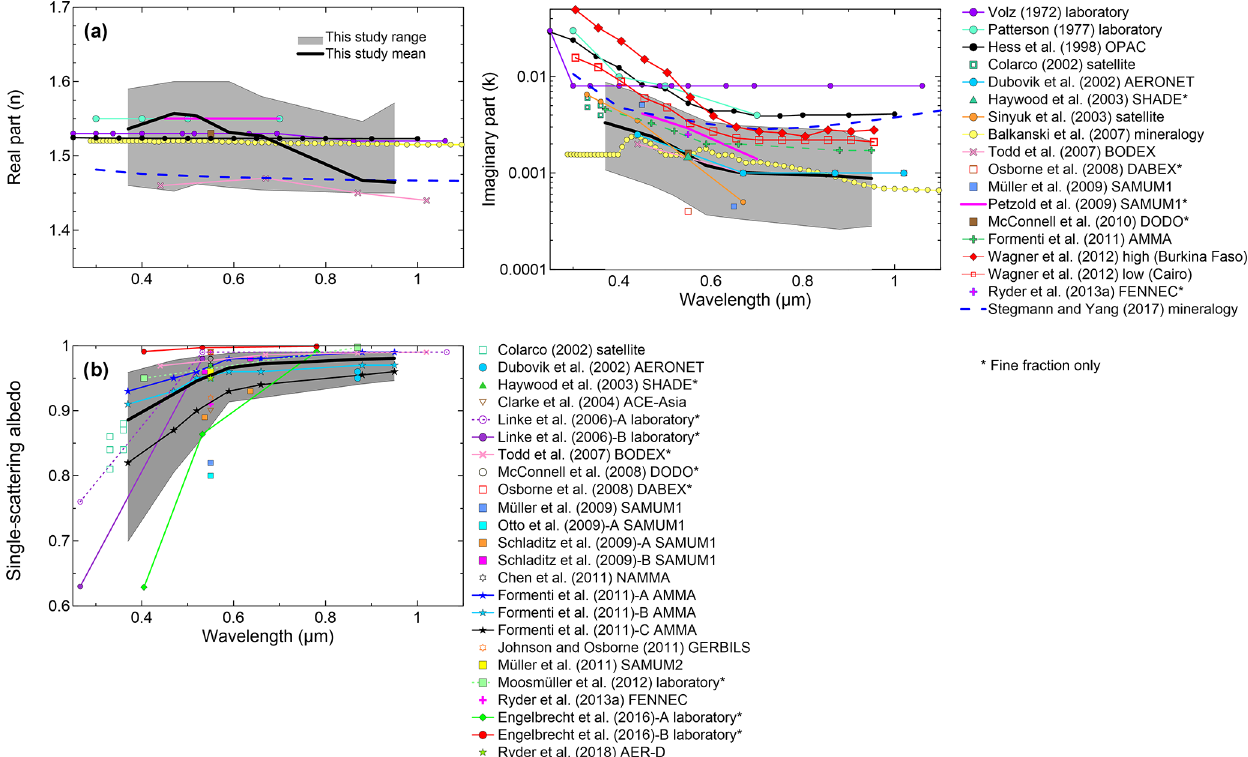
Figure 8. Comparison of the results obtained in this study with literature-compiled values of the (a) dust real and imaginary parts of the refractive index ( n , k ) and (b) single-scattering albedo (SSA) in the SW spectral range. The regions in grey indicate the full range of variability obtained in this study, and the thick black lines are the means of n , k , and SSA obtained for the different aerosol samples. Literature values include estimates from ground-based and aircraft observations during field campaigns, laboratory studies, AERONET inversions, and estimates from dust mineralogical composition. Data are in some cases for the full dust size distribution, while in others only the fine fraction below about 2µm is represented (identified with *). The main provenance of the dust and datasets from the literature is provided in the following: Volz et al. (1972) data are for rainout dust collected in Germany; Patterson et al. (1977) data are for Saharan dust; Hess et al. (1998) data are from the OPAC database; Colarco et al. (2002) data are for dust from Dakar, SAL, and Tenerife; Dubovik et al. (2002) include data from the Bahrain–Persian Gulf and Solar Village–Saudi Arabia AERONET stations; Haywood et al. (2003) include dust from Mauritania; Sinyuk et al. (2003) data are from Cape Verde, Dakar, and Burkina Faso; Clarke et al. (2004) include Asian dust offshore of China, Japan, and Korea; Linke et al. (2006)-A includes dust from Cairo; Linke et al. (2006)-B includes dust from Morocco; Balkanski et al. (2007) calculated data from the mineralogical composition assuming a 1.5% hematite mass fraction in dust; Todd et al. (2007) data are from Bodélé; Osborne et al. (2008) data are from Niger; Otto et al. (2009), Petzold et al. (2009), Schladitz et al. (2009), and Müller et al. (2009, 2011) include dust originated mostly in Morocco; McConnell et al. (2008, 2010) include dust from Niger–Senegal; Chen et al. (2011) include dust from the western Sahara; Formenti et al. (2011) in the k plot represents an average of airborne observations for the AMMA campaign in Niger, while for the SSA plot, Formenti et al. (2011)-A represents observations in the Saharan Air Layer, Formenti et al. (2011)-B data are from Bodélé–Sudan, and Formenti et al. (2011)-C represents a Sahelian uplift episode; Johnson and Osborne (2011) include dust from the western Sahara; Moosmüller et al. (2012) analyzed samples from the Middle East, Mali, and Spain, and here we report the average of their obtained values; Wagner et al. (2012) obtained k values for several samples from Burkina Faso, Cairo, and the SAMUM campaign, and here we report the values for the maximum of their spectral k (Burkina Faso) and the minimum (Cairo); Ryder et al. (2013a) include dust from the western Sahara and Mauritania, and we report in both the k and SSA plots the average of their observations; Engelbrecht et al. (2016) analyzed many dust samples from all over the world, and here we report their estimated minimum and maximum of the dust SSA (A) from California and (B) from the Etosha Pan in Namibia; Stegmann and Yang (2017) modeled the refractive index of dust based on assumed mineralogical compositions typical for the northern and southern Sahara and western and eastern Asia dust, and here we report the average of their results for both n and k . Uncertainties in the field observations have been omitted for the sake of clarity. The legend identifies the line styles used in the plots. The different acronyms are spelled out as follows (see also the caption of Fig. 4). AERONET: Aerosol Robotic Network; OPAC: Optical Properties of Aerosols and Clouds; SHADE: Saharan Dust Experiment; BODEX: the Bodélé Dust Experiment; DABEX: Dust and Biomass Experiment; SAMUM1 and SAMUM2 refer to the two SAMUM campaigns in Morocco and Cape Verde, respectively, SAMUM: Saharan Mineral Dust Experiment; DODO: Dust Outflow and Deposition to the Ocean; ACE-Asia: Asian Pacific Regional Aerosol Characterization Experiment; GERBILS: Geostationary Earth Radiation Budget Intercomparison of Longwave and Shortwave